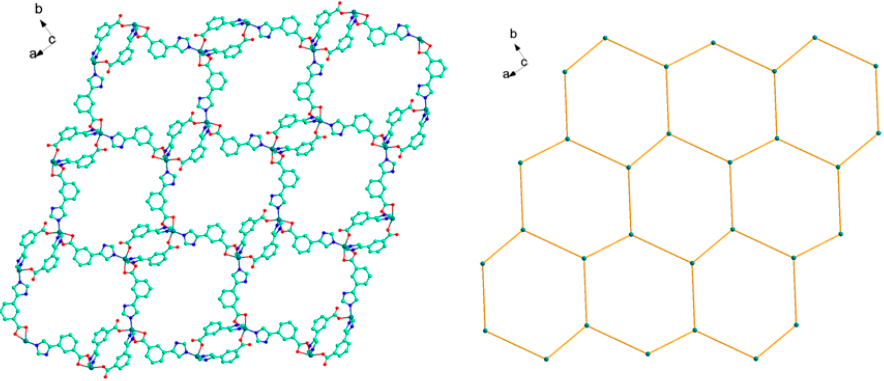
Figure 5. The 2D network structure (left) and the representation of 6 3 - hcb framework of 2 (right).